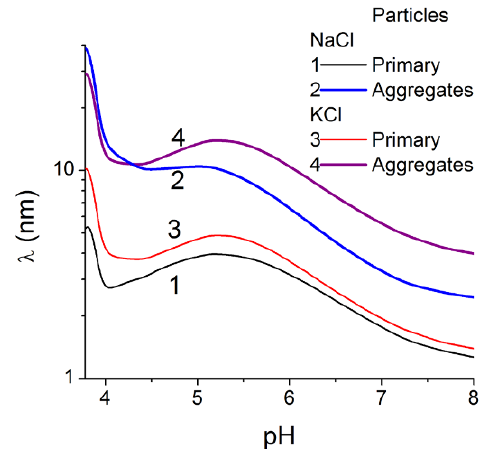
Figure 8. Effective screening length as a function of pH for individual nanoparticles (curves 1 and 3) and their = 0.001M NaCl (1, 2) or KCl aggregates (2, 4) at C salt = 5 wt.%. (3, 4) and C A-200